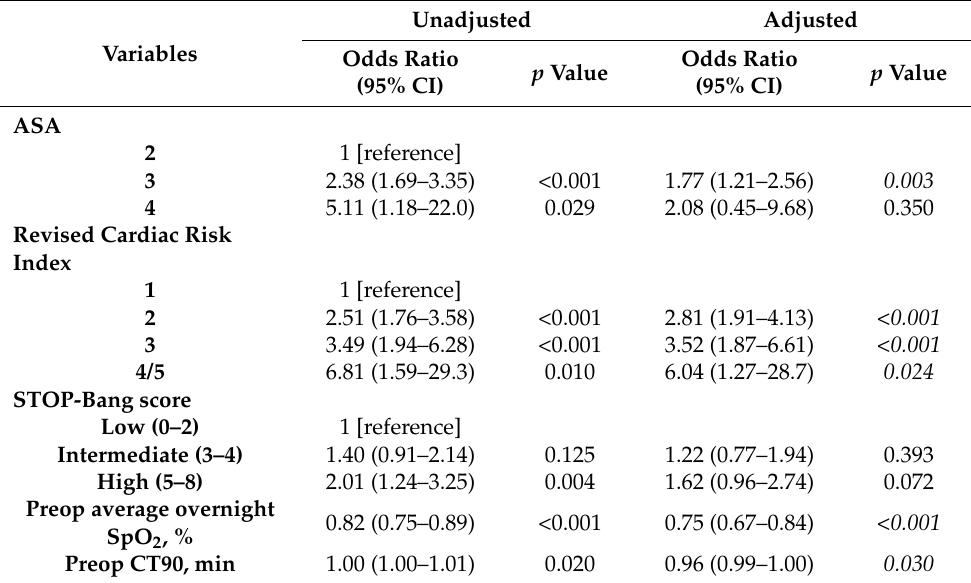
Table 2. Multivariable logistic regression analysis for patients with unrecognized OSA requiring oxygen